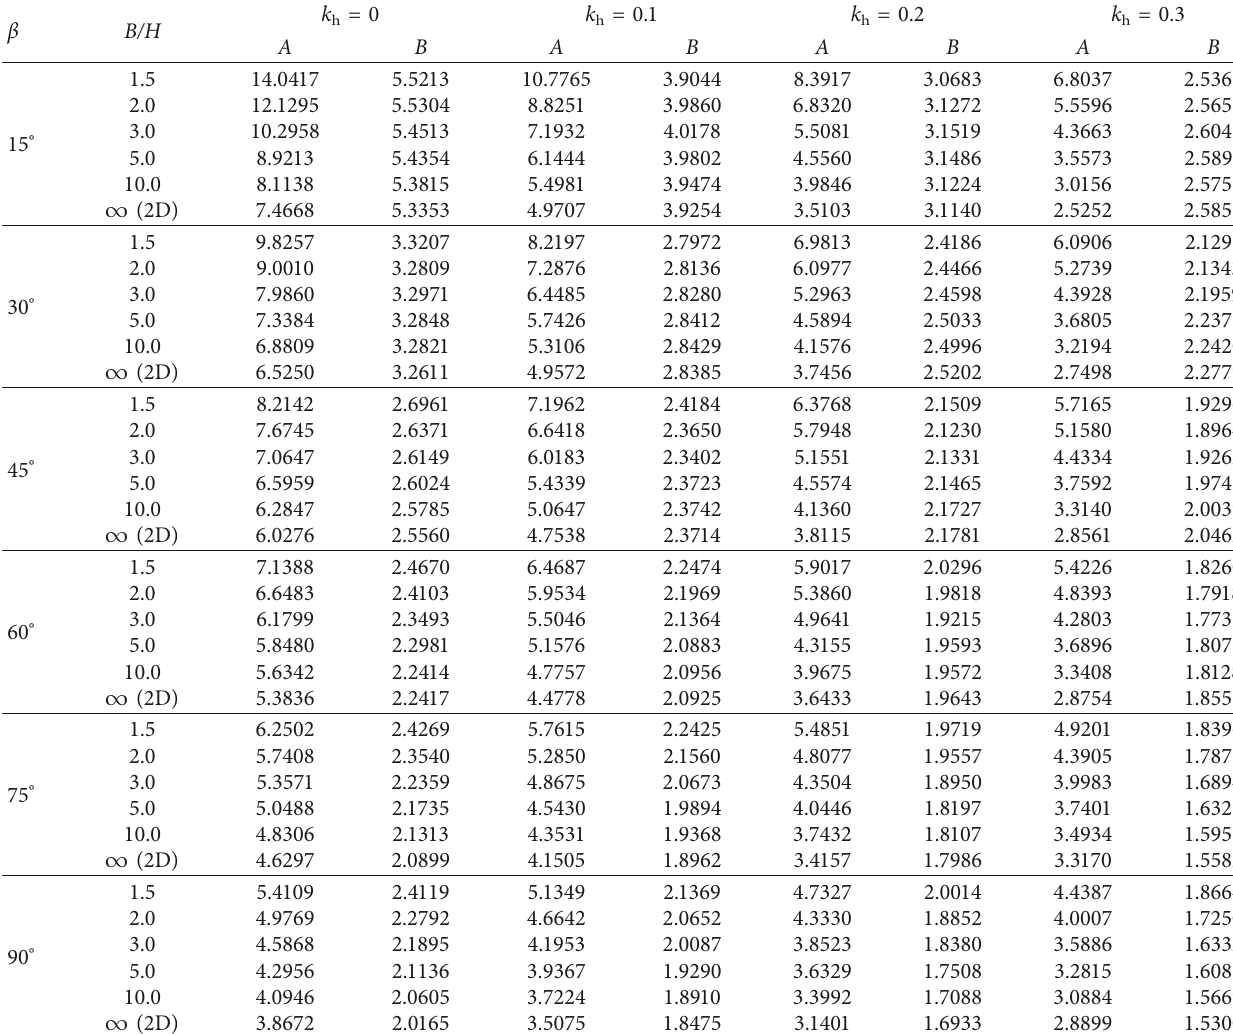
Table 3: Coefficients A and B in equation (12) for natural slopes.